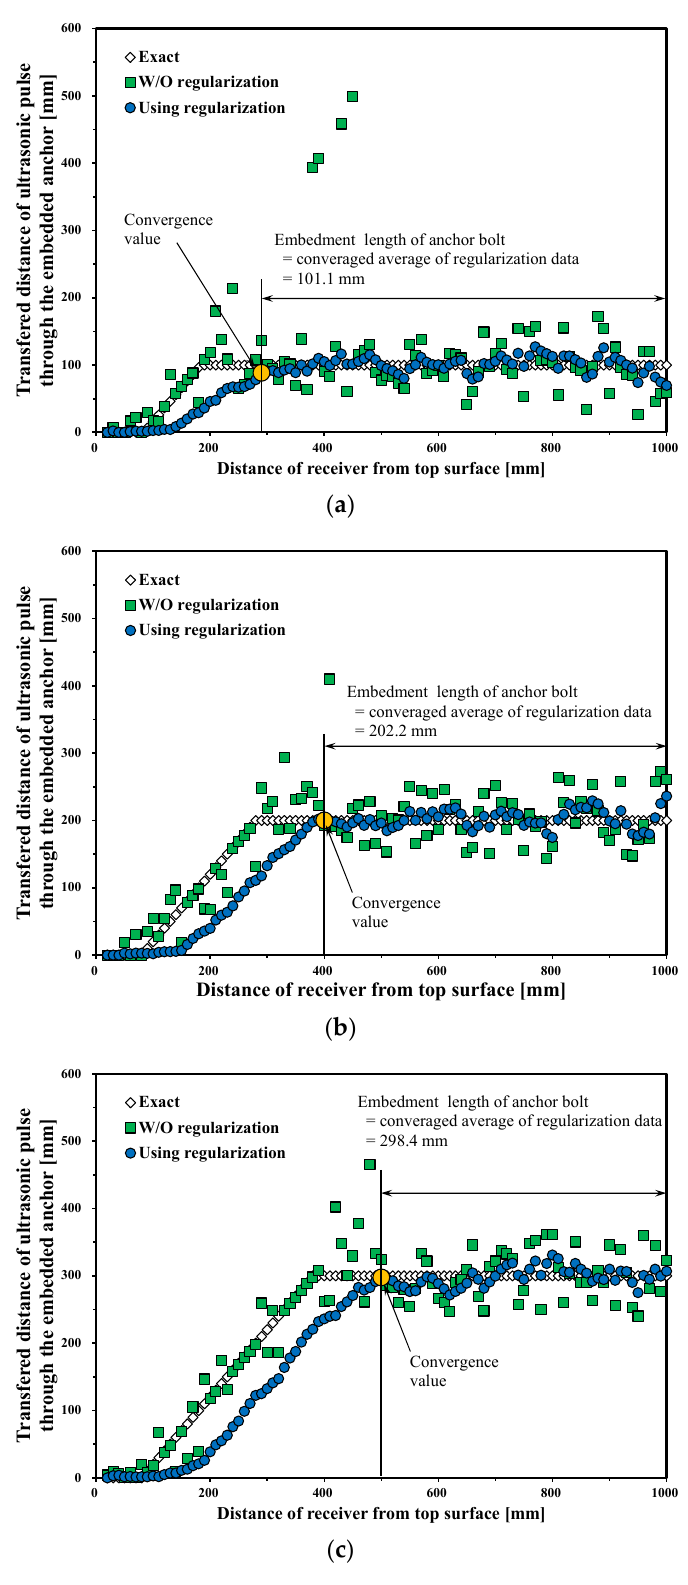
Figure 5. Results of the numerical verification for white noise and regularization in specimens with a cover thickness of 100 mm: ( a ) E100C100; ( b ) E200C100; ( c ) E300C100.